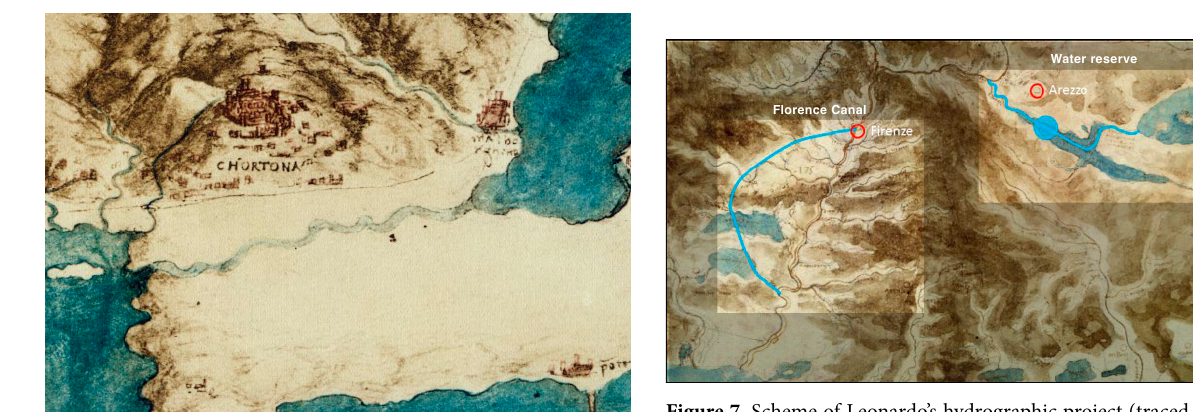
Figure 6. Detail of the southern emissary of the Lake Trasimeno from the Map of Valdichiana , Windsor, Royal Library, 12278r.